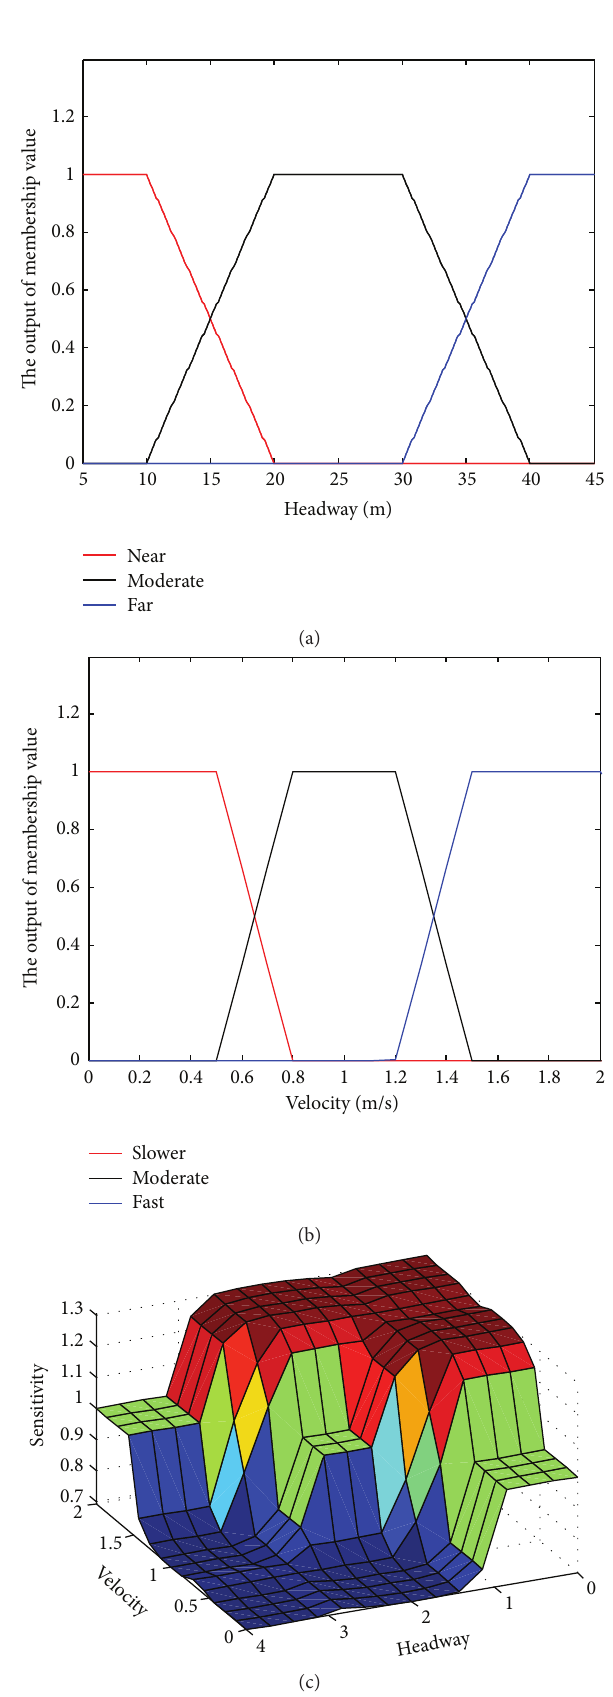
Figure 2: Membership functions of speed and headway and the input or output of curved